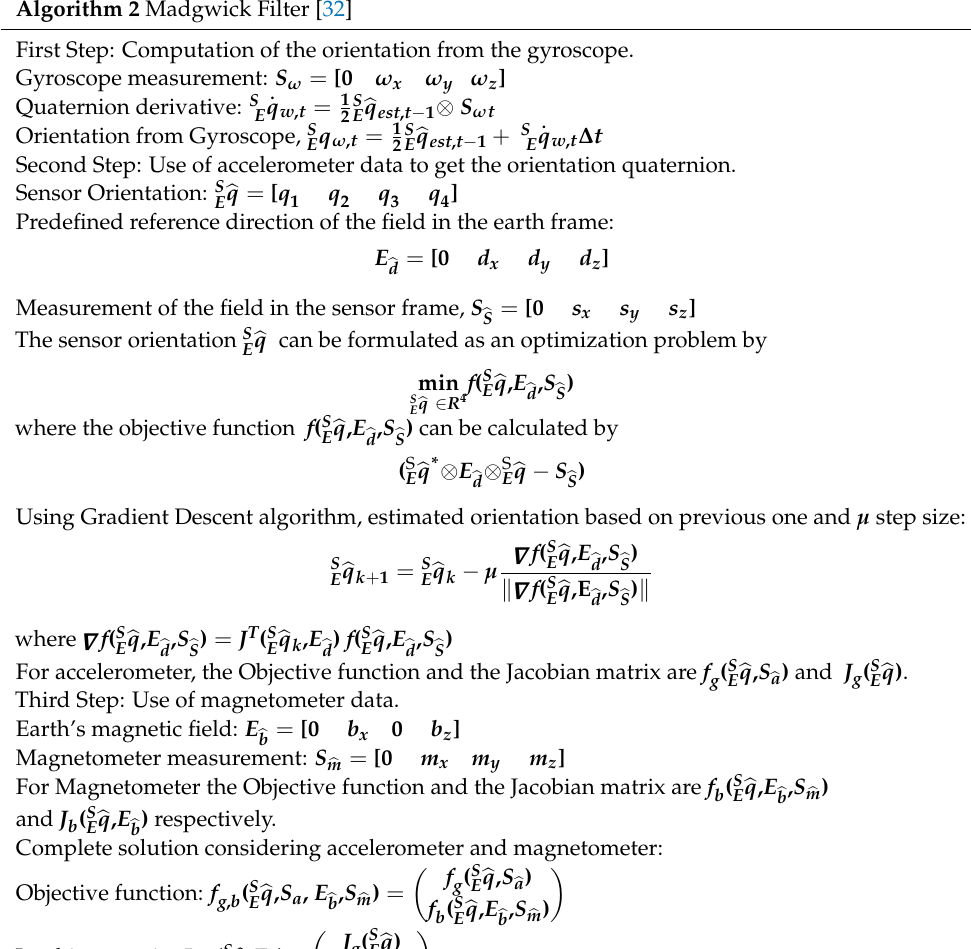
Algorithm 2 Madgwick Filter [32]